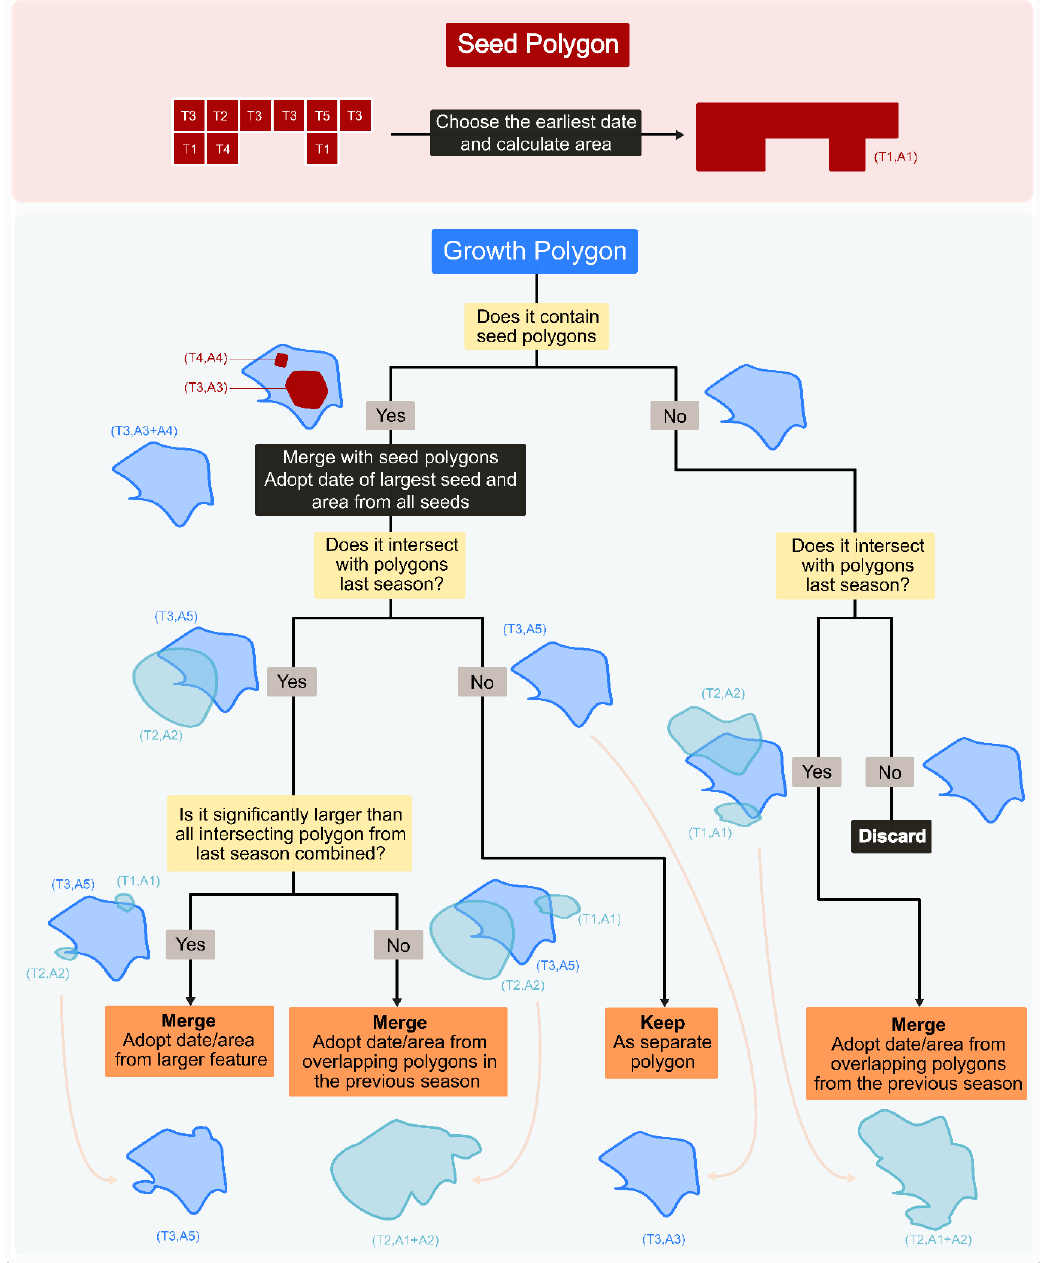
Figure 6. Decision tree for iterative polygon merging based on the date (T) and area (A) of seed polygons.